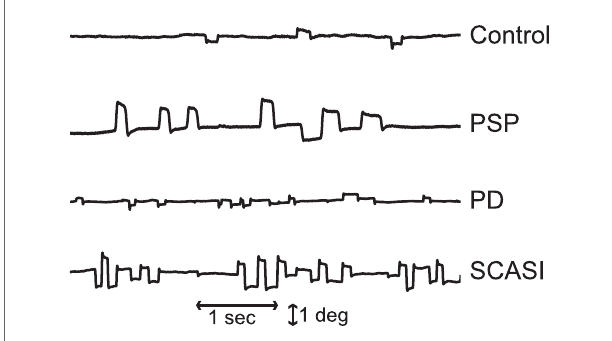
FigUre 1 | Example of microsaccades and saccadic intrusions during attempted fixation in control subjects and patients with parkinsonian disorders: progressive supranuclear palsy (PSP), Parkinson’s disease (PD), spinocerebellar ataxia with saccadic intrusions (SCASI). Figure adapted from Otero-Millan et al.